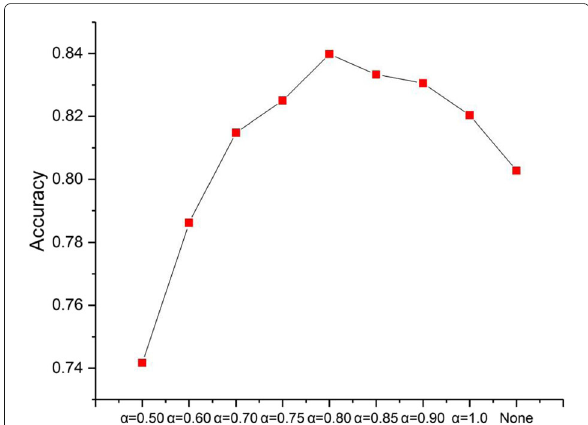
Fig. 5 Total accuracy when α takes different values part of speech tagging, improved CHI formula and syn- onym merging. In addition, this paper proposes an update method for calculating the weight of feature words after synonym merging to obtain a more accurate vector repre- senting of the text for classifier processing. The results of the experiment proves that the feature dimension can be reduced and the accuracy and effectiveness of text clas- sification can be improved at the same time with this method.